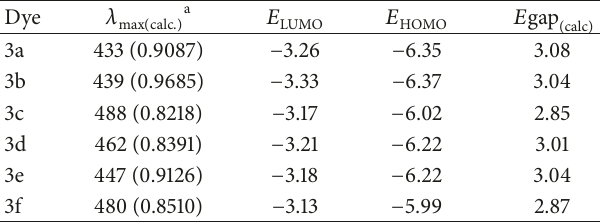
Table 8: HOMO and LUMO energies (eV), energy gaps ( Δ𝐸 ), and 𝜆 max values (nm) of azo dyes 3a–3f calculated in